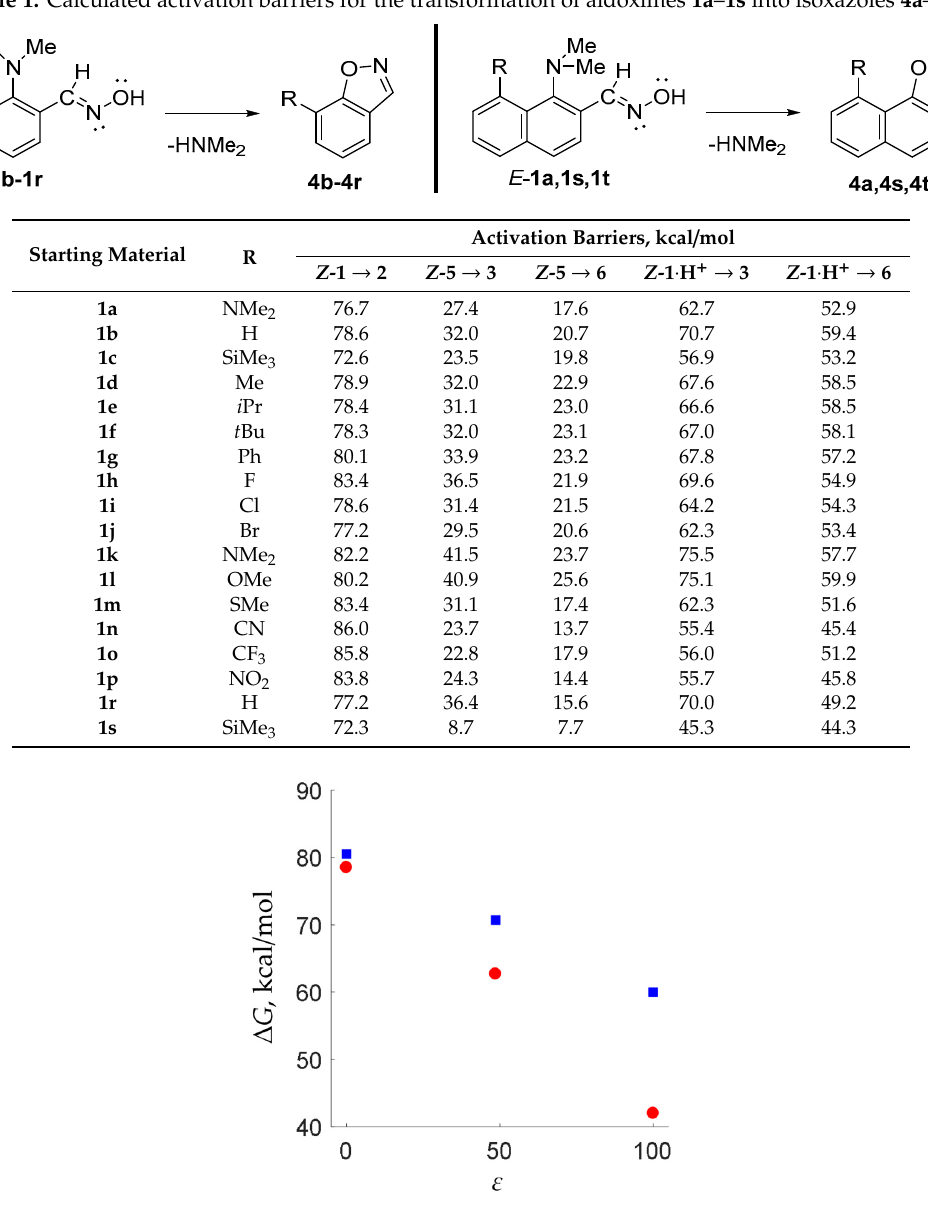
Figure 7. Activation barriers for Z - 1a · H + → 3a (red circles) and Z - 1b · H + → 3b (blue squares) calculated with ε = 1 (vacuum), ε = 48.6 (dimethyl sulfoxide) and ε = 100.